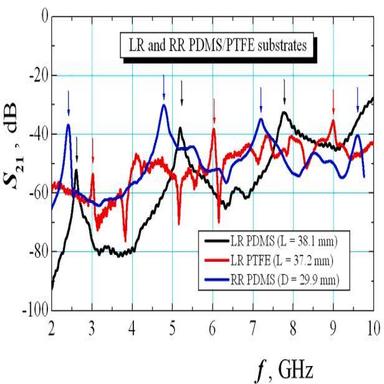
Measured resonance curves (2–10 GHz) of the first 3–4 q-TEM modes in linear (LR) and ring (RR) microstrip resonators on PDMS (0.75 mm thick) and PTFE (0.48 mm thick) substrates.